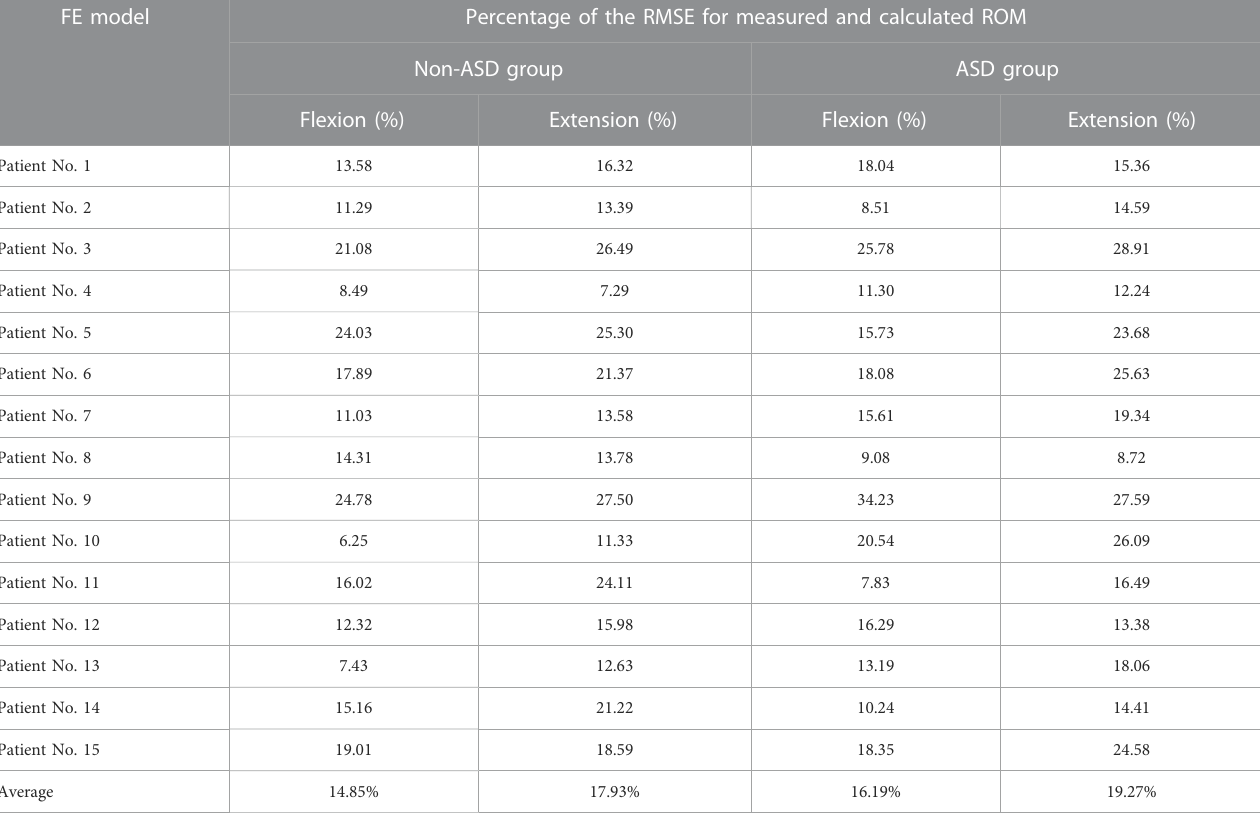
TABLE 2 Calculated percentage of root mean square errors (RMSE) for evaluating the accuracy and validity of the personalized pre-operative (pre-op) FE models for non-ASD patients (N = 15) and ASD patients (N = 15). FE model Percentage of the RMSE for measured and calculated ROM Non-ASD group ASD group Flexion (%) Extension (%) Flexion (%) Extension